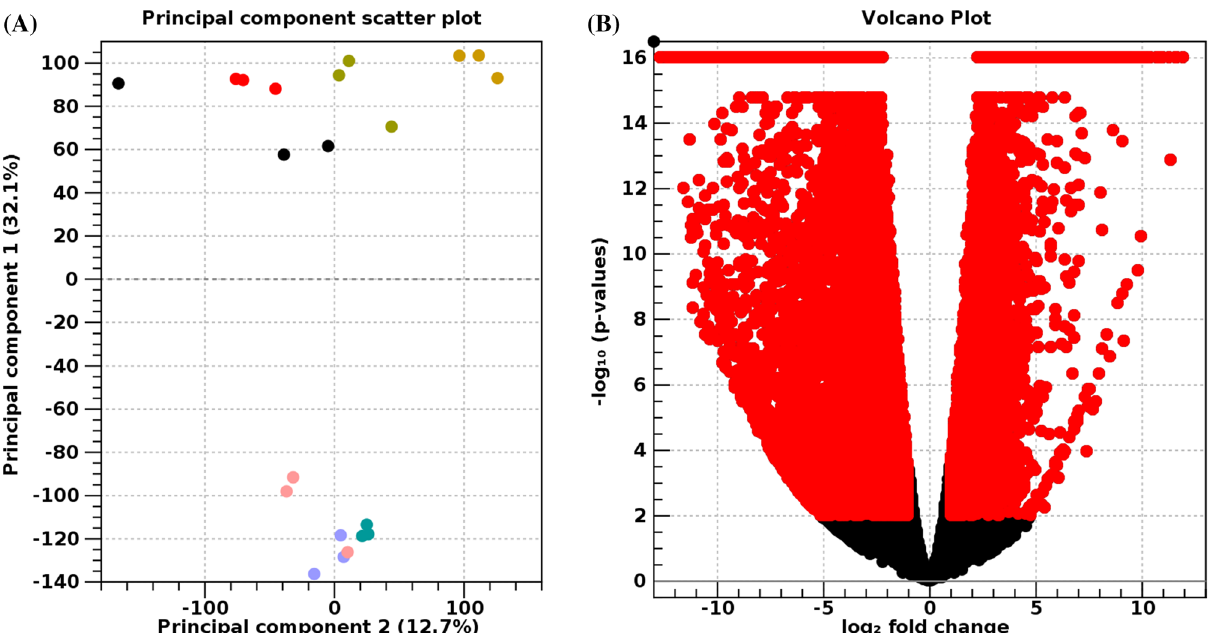
Figure 2. Adult individuals and larval state of B. wellingtonensis show a unique transcriptional signature. ( A ) Principal component analysis of the 21 RNAseq sample shows clustering into adult and larval groups. Upper circles show larval samples: EAL (red), AL (black), PLTIII (green) and PLTI (yellow). Lower circles show adult samples: FTIII (pink), FTI (lilac), and M (calypso). ( B ) Volcano plot comparison of differential gene expression between larvae and adults. Red dots highlight differentially expressed genes with threshold FDR < 0.01 and Log2 Fold Change [≥ 1]. The black zone indicates the number of transcripts that do not show significant differential